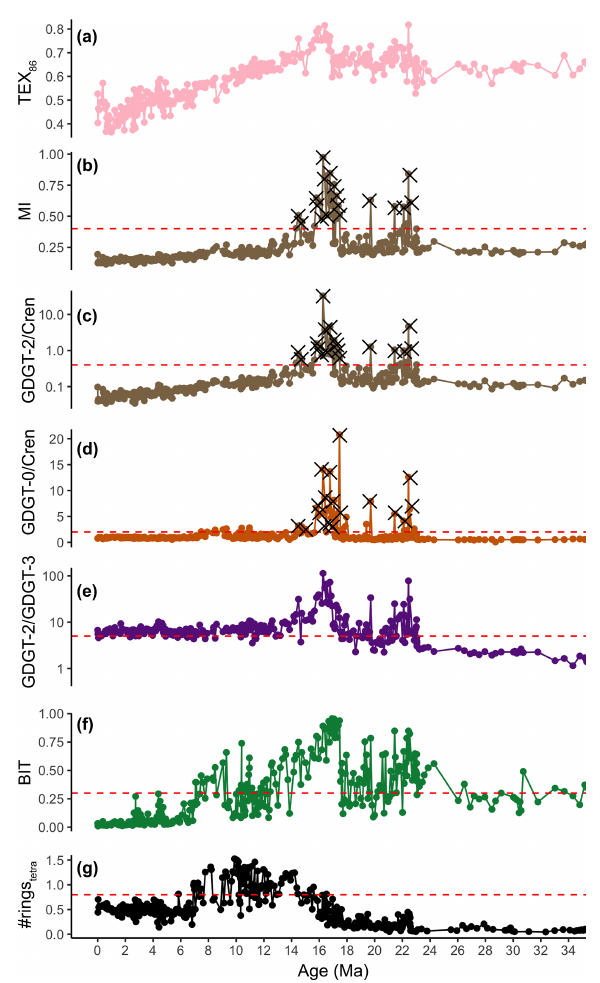
Figure 3. TEX 86 values and indices and ratios to detect non- thermal GDGT contributions. Dashed red lines indicate proposed threshold values. (a) TEX 86 . (b) Methane index, threshold = 0.4 (Zhang et al., 2011). (c) GDGT-2 / cren, threshold = 0.4 (Wei- jers et al., 2011). (d) GDGT-0 / cren, threshold = 2 (Blaga et al., 2009). (f) BIT, usually applied threshold = 0.3 (Hopmans et al., 2004). (e) GDGT-2 / GDGT-3, threshold = 5 (Taylor et al., 2013). (g) #rings tetra , threshold = 0.8 (Sinninghe Damsté, 2016). Dis- carded data are shown by crosses.